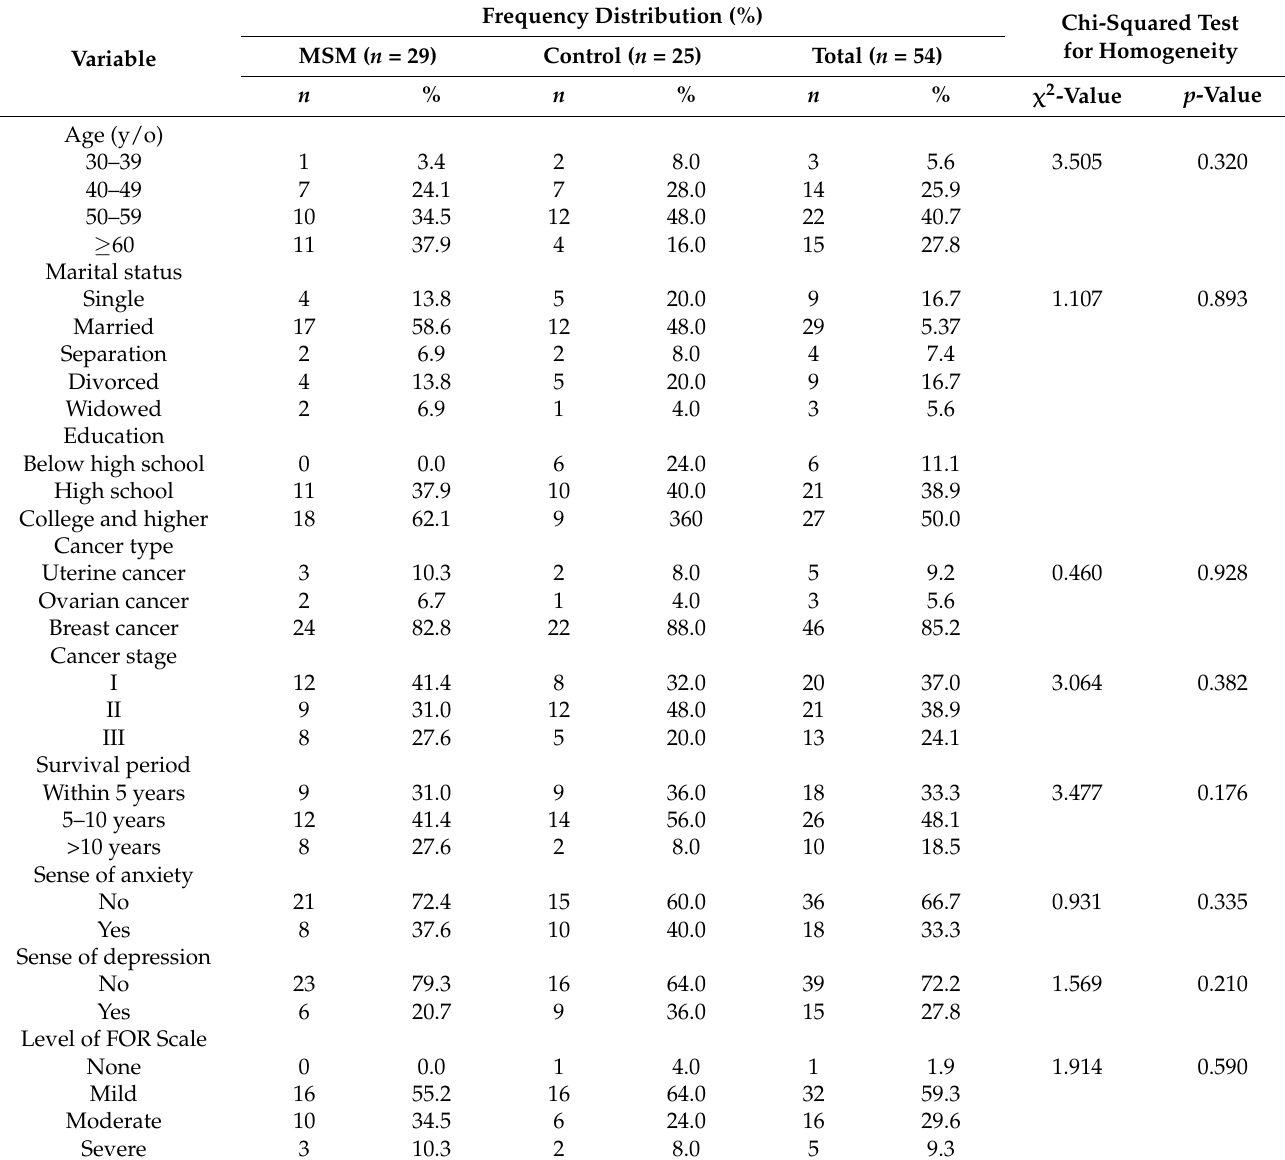
Table 1. Baseline characteristics of participants ( n =